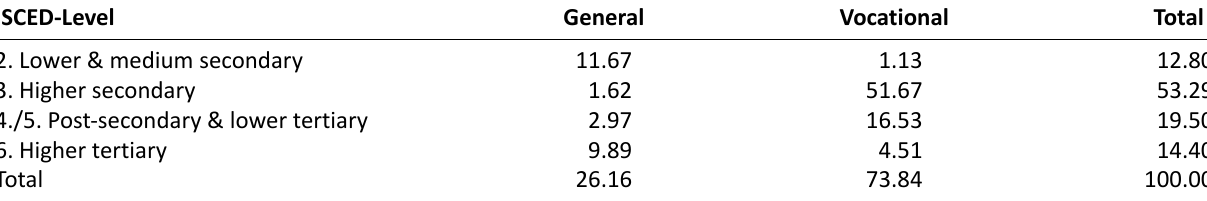
Table A3. Relative frequencies: General vs. vocational education. Data source: GSOEP (n.d.).